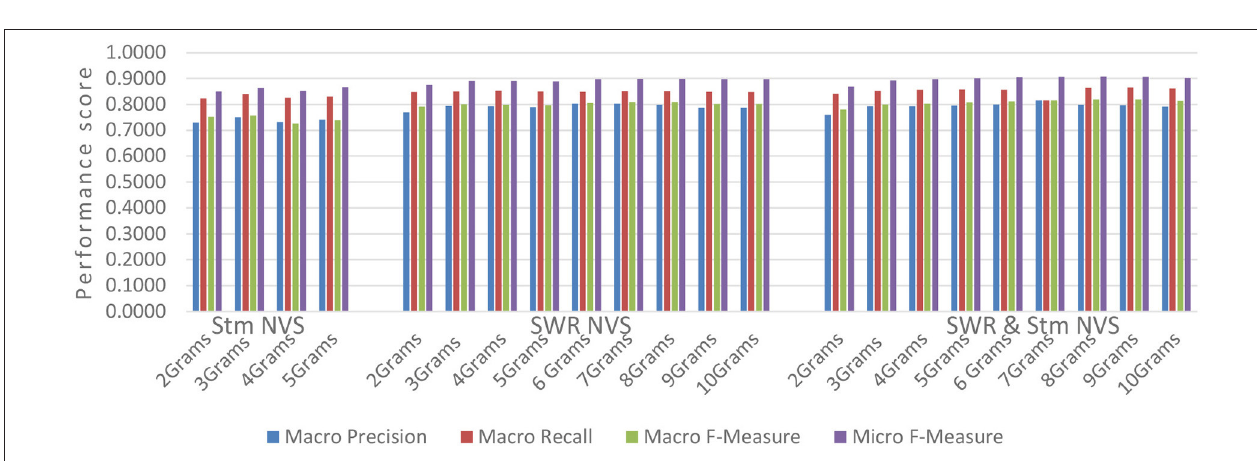
FIGURE 13 | Evaluating preprocessing techniques with Reuters-21578 and normalized value similarity.